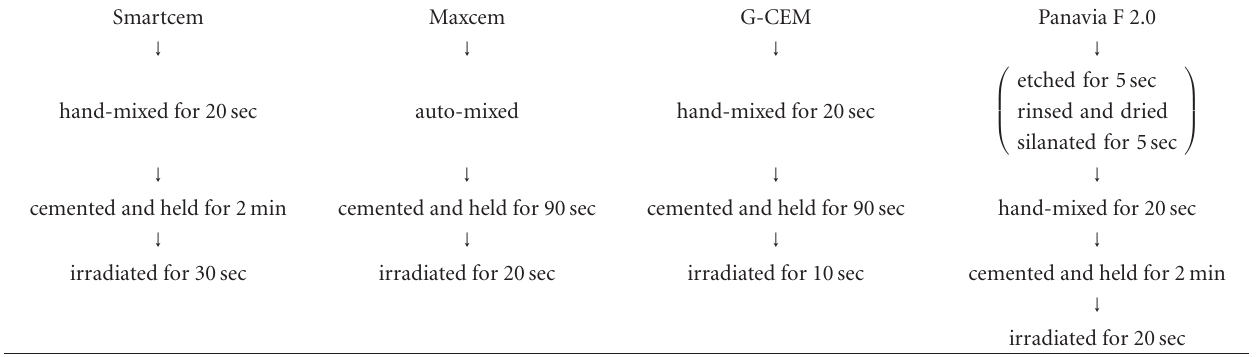
Table 2: The procedures for each resin-based composite luting cement.